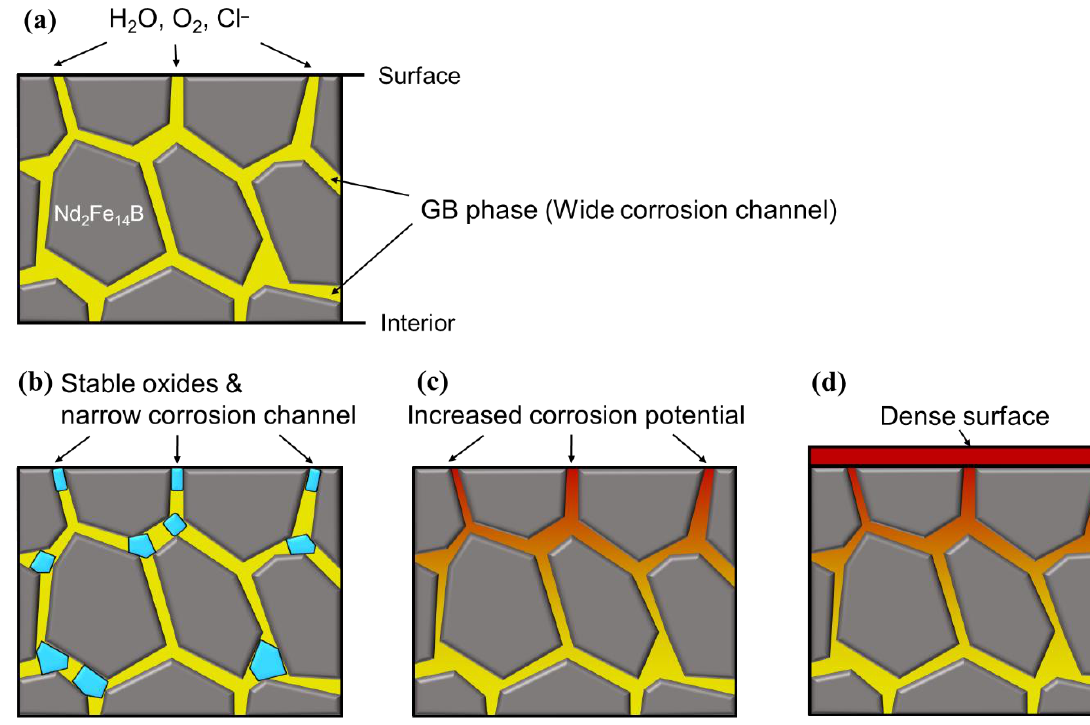
Figure 4. ( a ) The corrosion mechanism for Nd-Fe-B magnets. The schematic of improvement of corrosion resistance by GBDs by non-RE based ( b ) oxides, ( c ) low-melting metals/alloys, and ( d ) high-melting alloys.